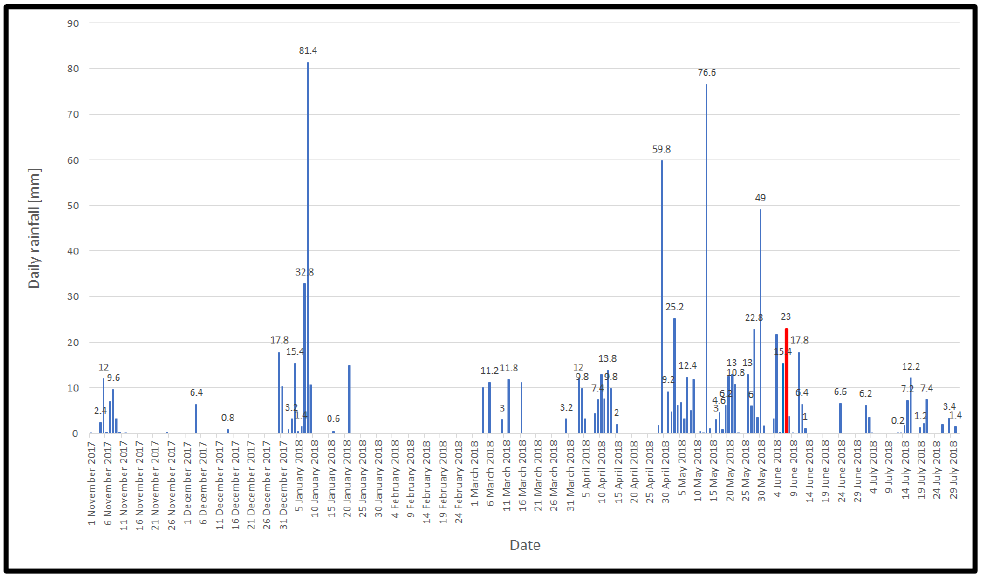
Figure 18. Hourly and accumulated rainfall recorded by Prarotto raingauge from fall wildfire to June 2018. Debris flow occurrence day in red.